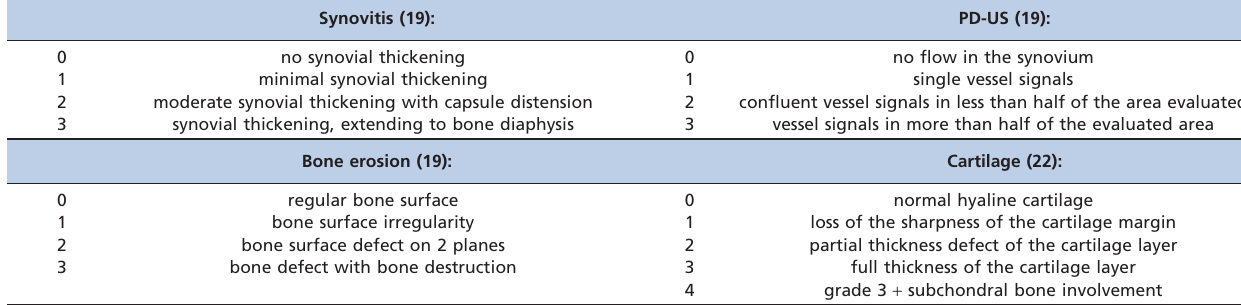
Table 1 - Semiquantitative scores for synovitis, PD-US, bone-erosion and cartilage. Synovitis